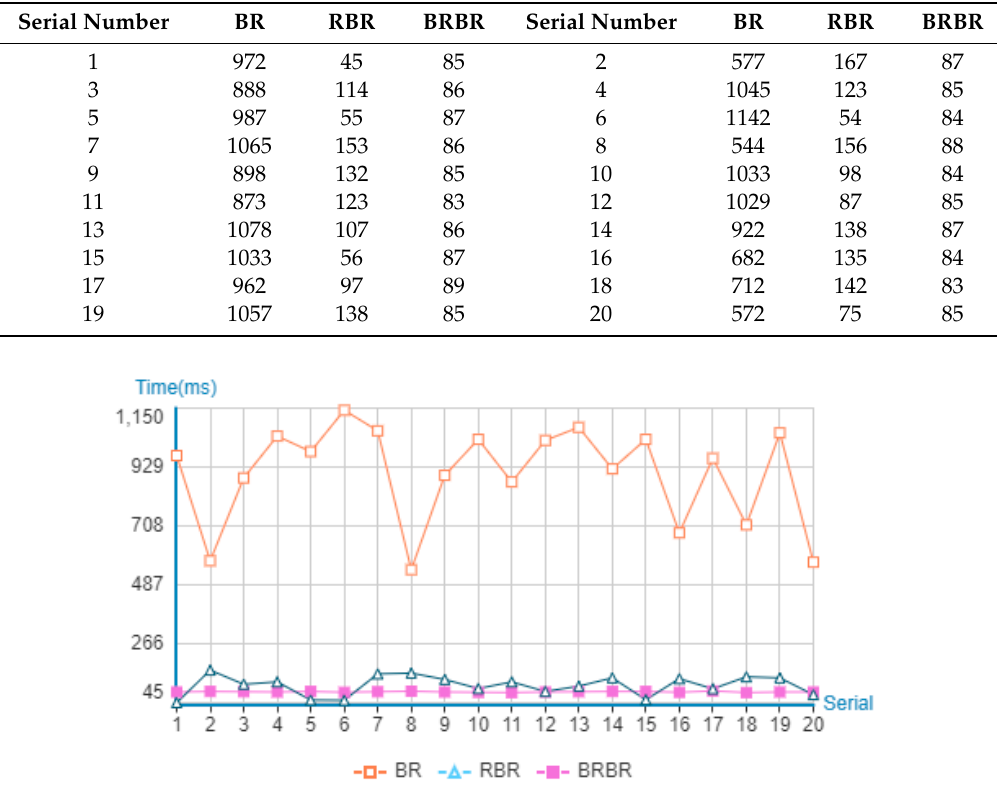
Figure 16. First response time of three retrieval algorithms in block retrieval.